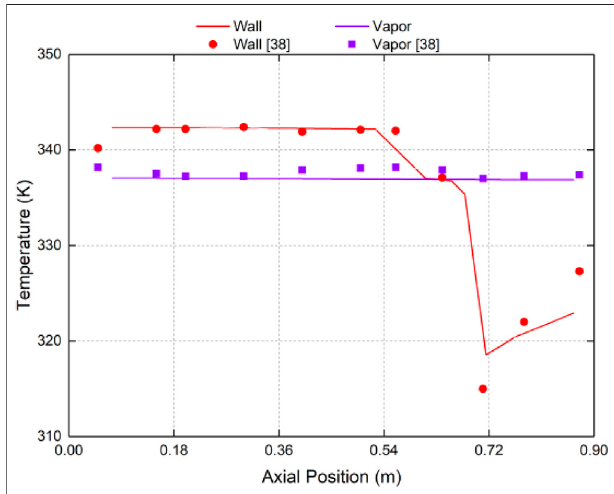
FIGURE 12 | Calculated temperature distribution in the steady state.